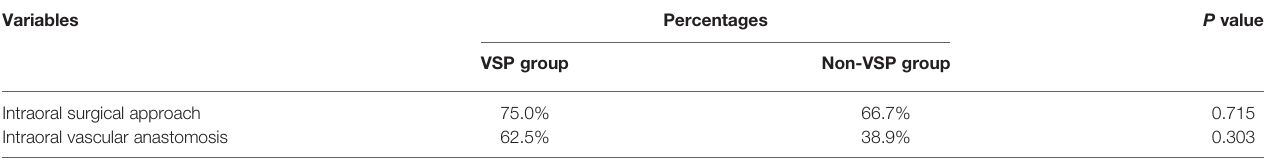
TABLE 2 | Choice of surgical approach and vascular recipient area in the VSP and non-VSP groups.